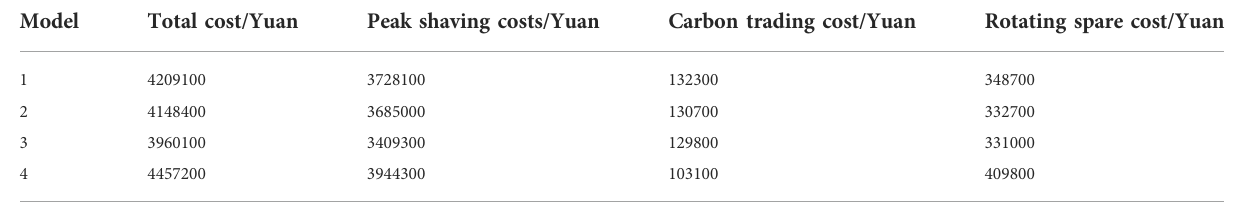
TABLE 4 Comparison of the calculation results of different